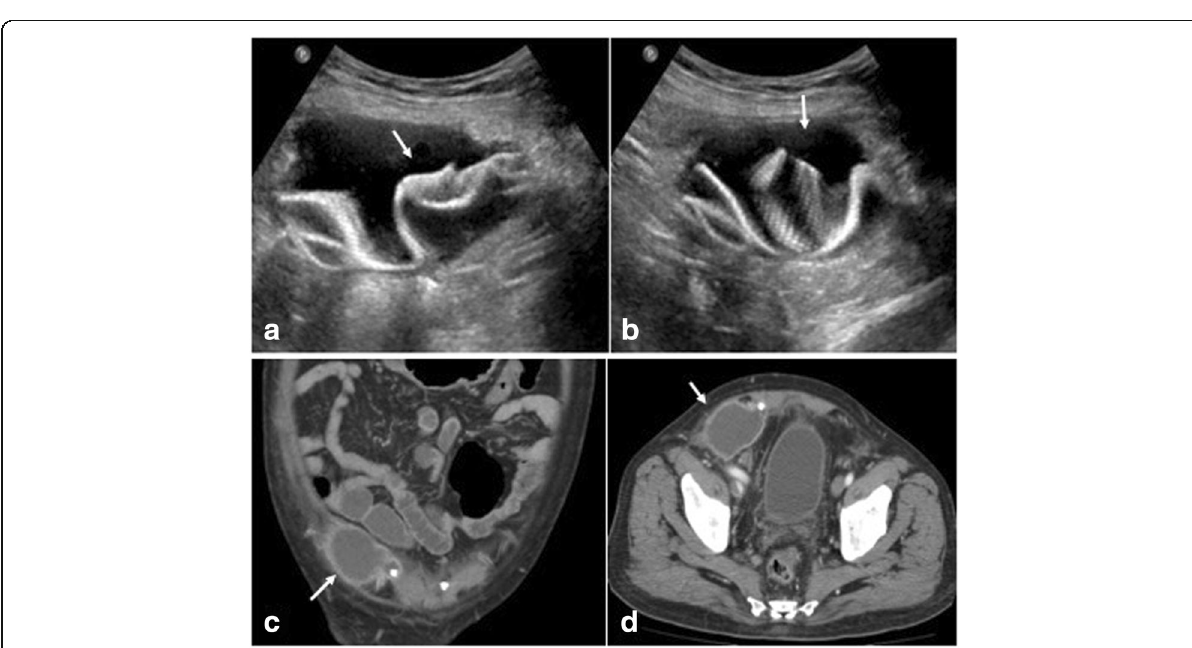
Fig. 12 Post right inguinal hernia repair. a , b USG shows migrated crumpled mesh within the collection (arrow). c , d CECT of the same patient shows only the collection (arrow) demonstrating the added utility of USG in mesh localization